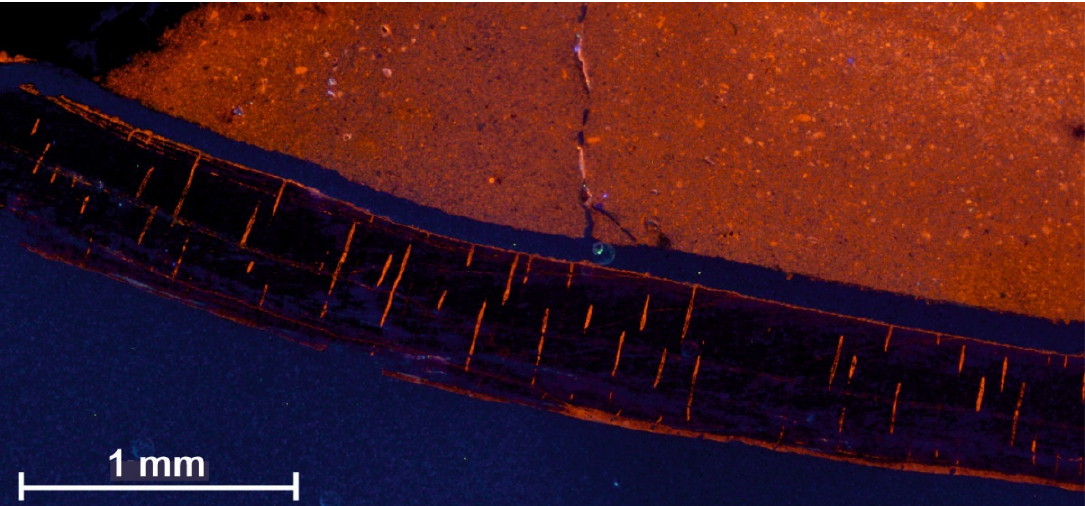
Figure 3. Cold cathodoluminescent image of an Upper Maastrichtian (Upper Cretaceous) terebratulid brachiopod shell from Chełm quarry (eastern Poland; cf. [111]). Puncta of the originally perforated shell are filled with luminescent diagenetic cements.